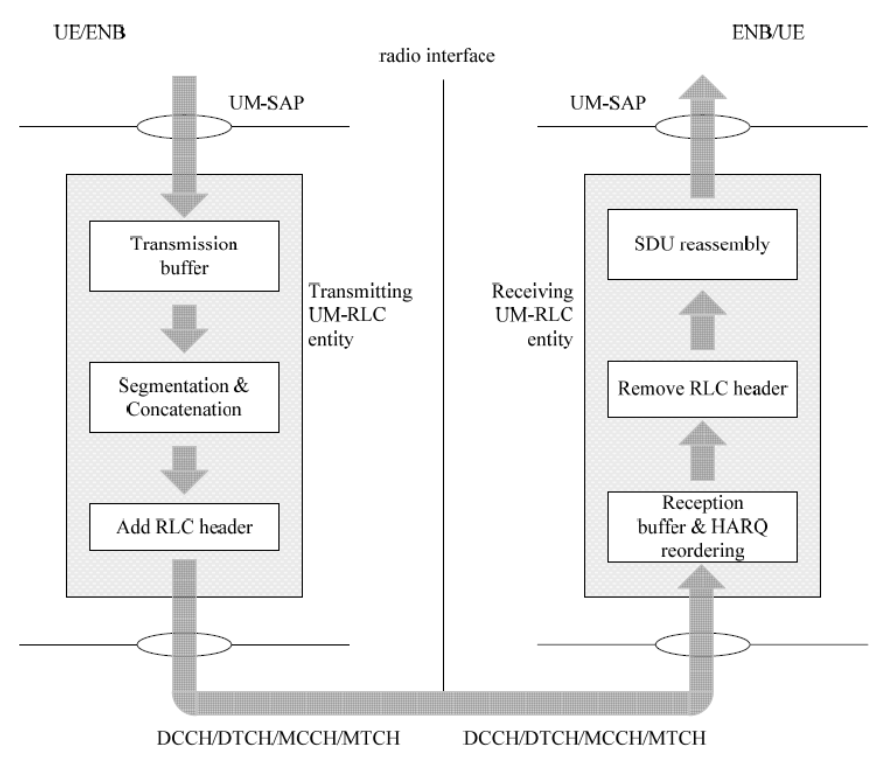
Figure 1. UM RLC entities. Reprinted with permission from ref. [20]. Copyright 2017